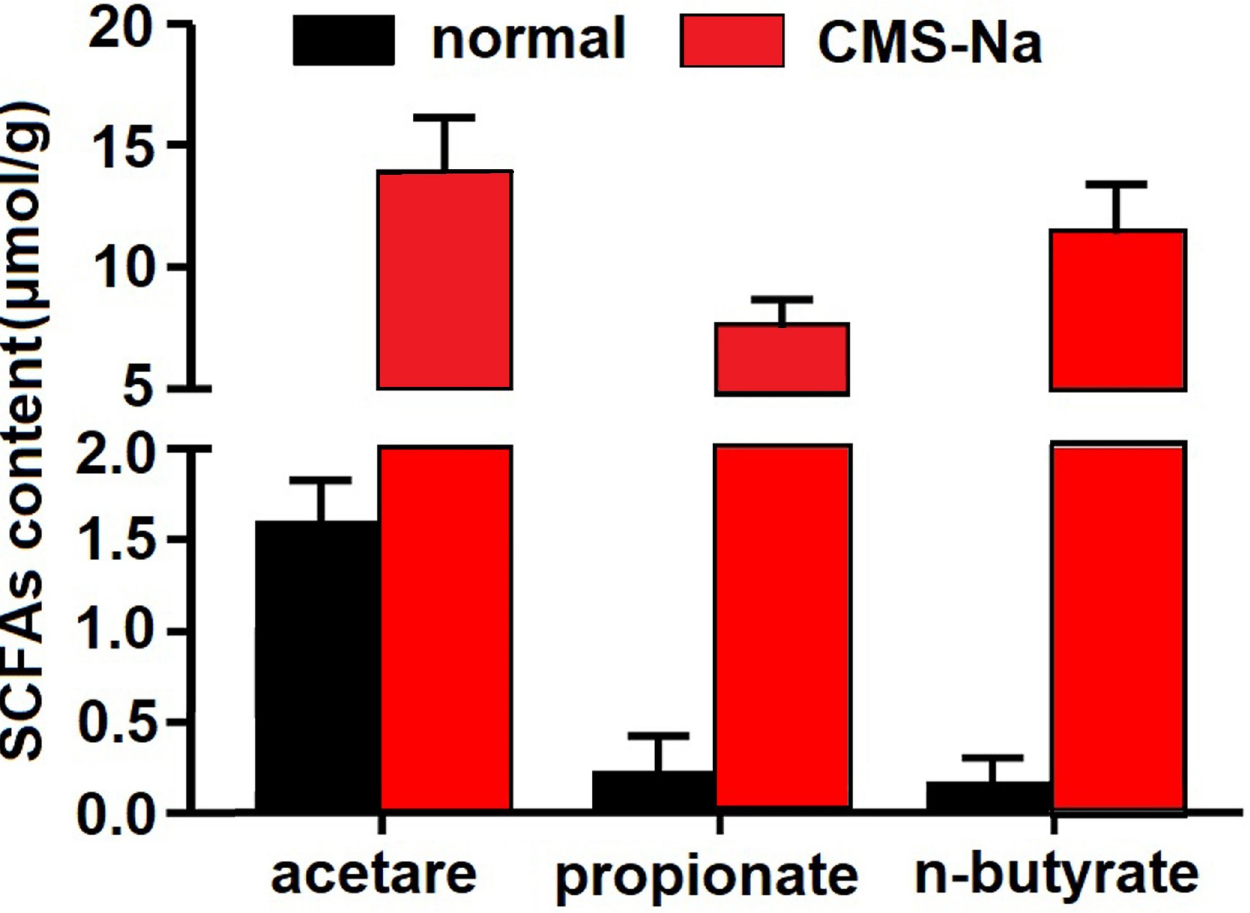
Fig 5. Effect of CMS-Na on the content of Short-Chain Fatty Acids (SCFAs) in rat feces. Rats were orally treated with 1.2 g � kg -1 CMS-Na once a day for 5 d. Then, approximately 500 mg feces were collected to detect the contents of SCFAs by gas chromatography. Mean ± SD, n = 10, � P < 0.05, �� P < 0.01, vs. normal.